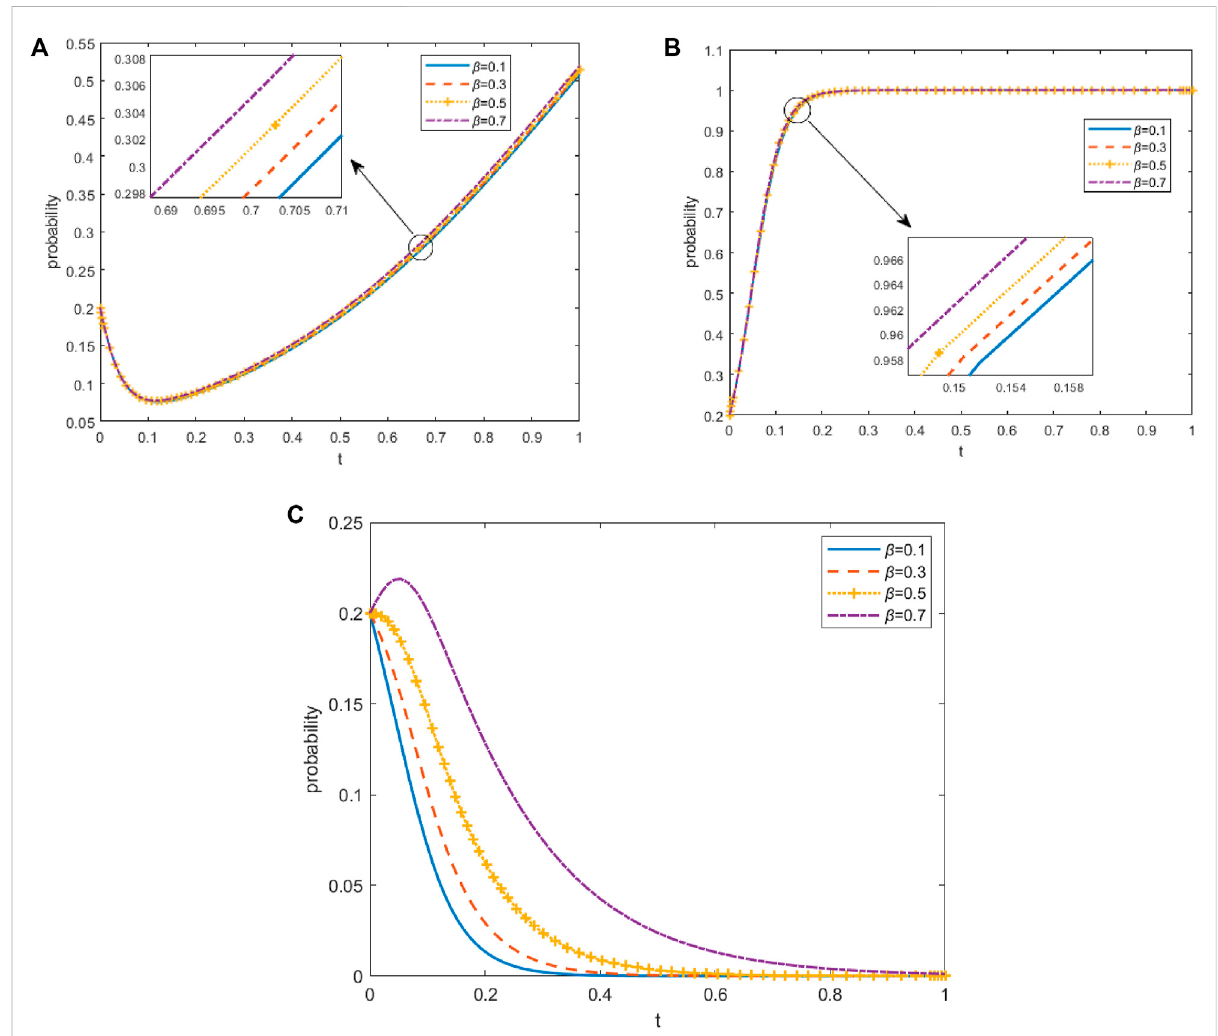
FIGURE 10 Effectof β ontheevolutionofthesystem. (A) Effectof β onfarmer ’ sstrategy, (B) Effectof β onthelocalgovernment ’ sstrategy, (C) Effectof β on the central government ’ s